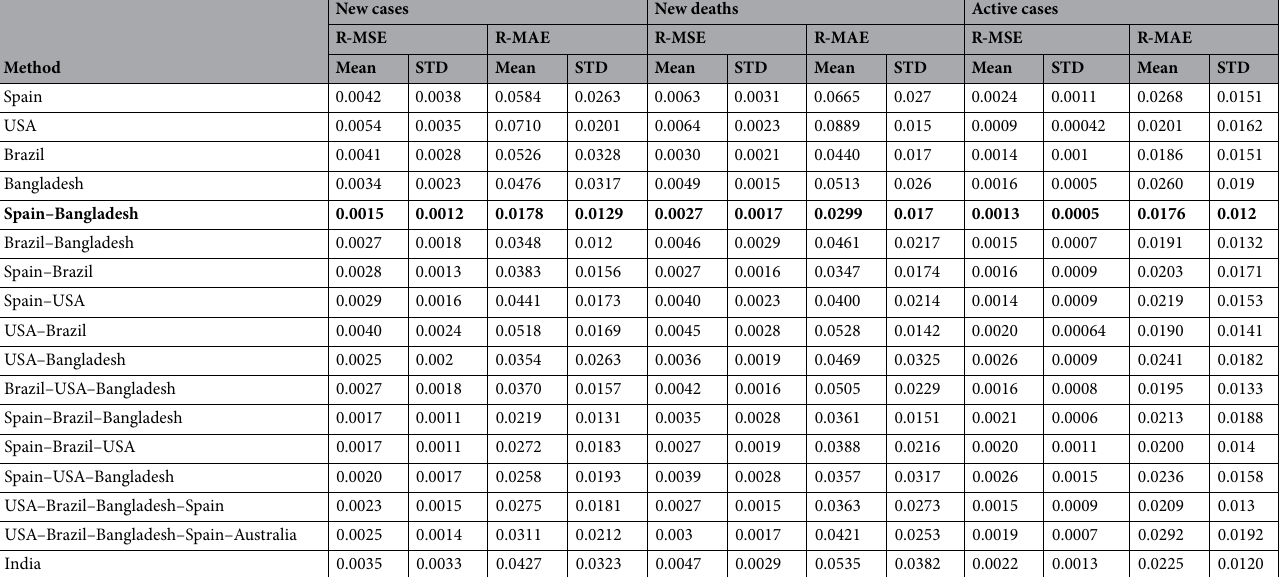
Table 3. Comparison of results i.e. Mean and Standard Deviation (STD) of 20 runs, from all possible combinations of four countries considered in this study. Similar configuration LSTM models, fine-tuned on Indian data, have been used in this case. Best results are in bold.